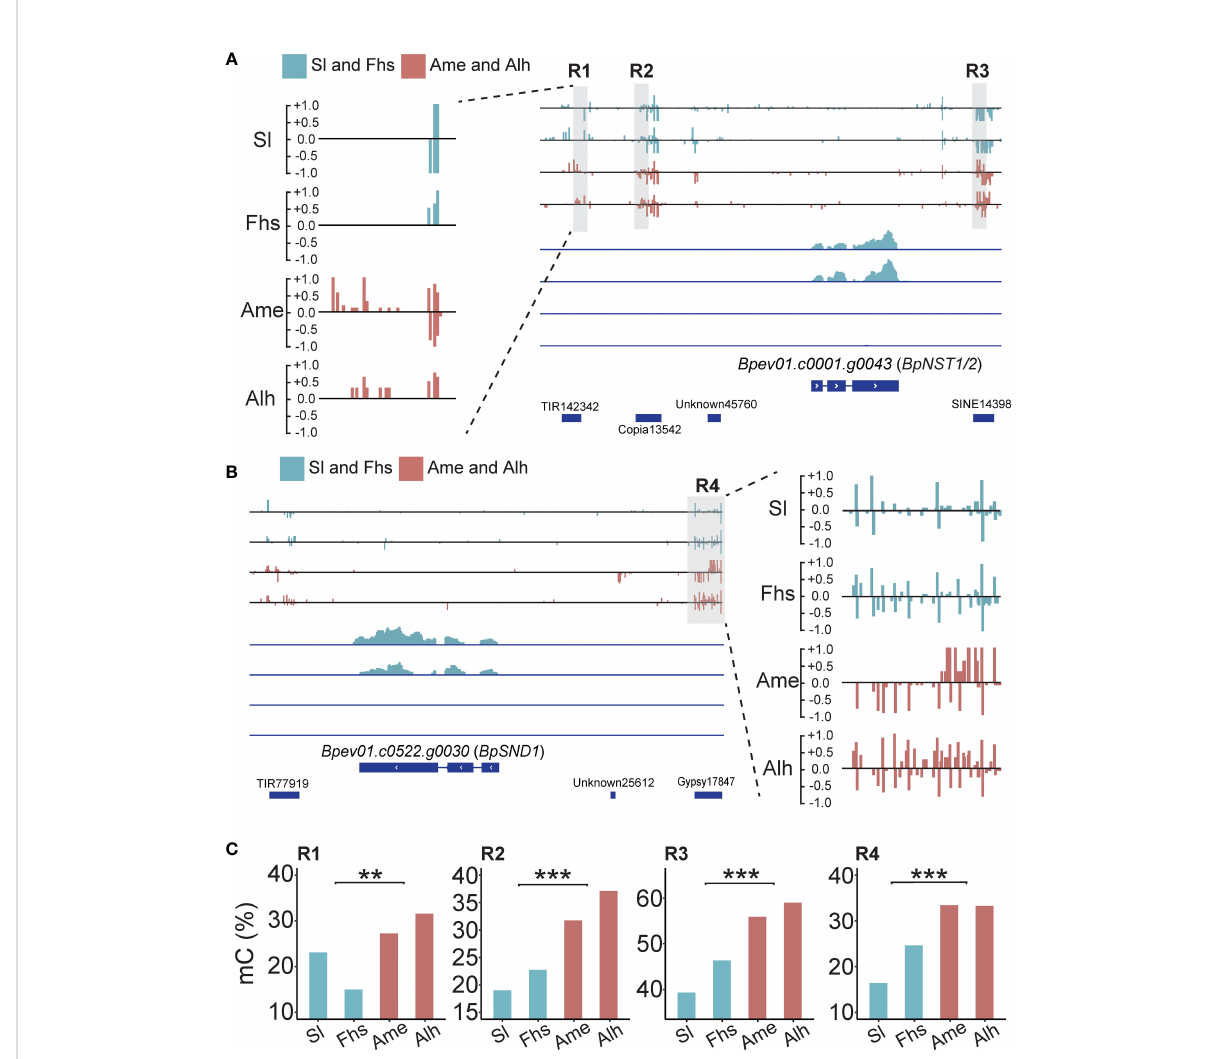
FIGURE 3 Methylation and expression pro fi les of BpNST1/2 and BpSND1 . (A) Methylation and transcript snapshot of BpNST1/2 in Sl, Fhs, Ame, and Alh. R1 (Chr5:20,594,500-20,594,600), R2 (Chr5:20,595,495-20,595,599) and R3 (Chr5:20,600,700-20,600,825) marked in grey box were identi fi ed as the DMRs nearby the BpNST1/2. The height of each column represents the methylation level at each cytosine. The lower part indicates the transcript level of BpNST1/2 , ranging from 0 to 100. (B) Methylation and transcript snapshot of BpSND1 in Sl, Fhs, Ame, and Alh. R4 (Chr14:277,350-277,600) marked in grey box was identi fi ed as the DMRs located in promoter of BpSND1. The lower part indicates the transcript level of BpSND1 , ranging from 0 to 30. (C) DNA methylation level of R1-R3 ( BpNST1/2 ) and R4 ( BpSND1 ) in Sl, Fhs, Ame, and Alh. The p ≤ 0.01 is marked as ‘ ** ’ and p ≤ 0.001 is marked as ‘ *** ’